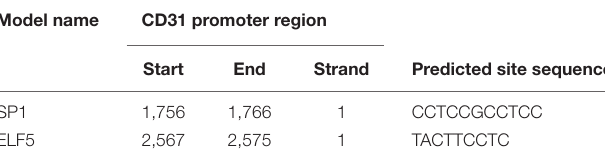
TABLE 2 | The predicted binding sites between SP1/ELF5 and